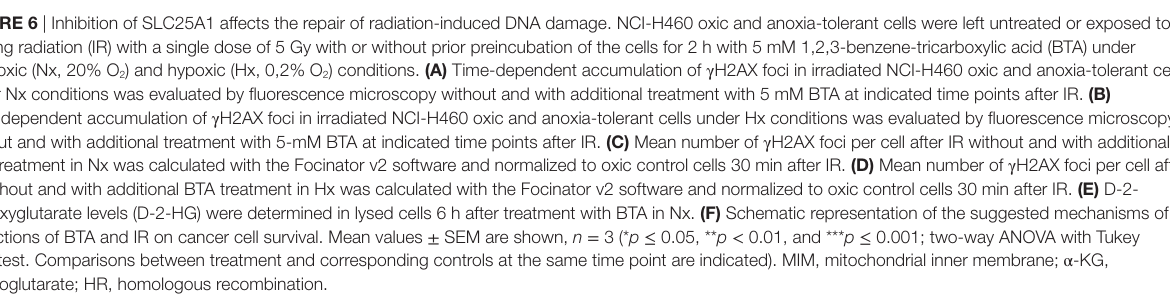
FigUre 6 | Inhibition of SLC25A1 affects the repair of radiation-induced DNA damage. NCI-H460 oxic and anoxia-tolerant cells were left untreated or exposed to ionizing radiation (IR) with a single dose of 5 Gy with or without prior preincubation of the cells for 2 h with 5 mM 1,2,3-benzene-tricarboxylic acid (BTA) under normoxic (Nx, 20% O 2 ) and hypoxic (Hx, 0,2% O 2 ) conditions. (a) Time-dependent accumulation of γ H2AX foci in irradiated NCI-H460 oxic and anoxia-tolerant cells under Nx conditions was evaluated by fluorescence microscopy without and with additional treatment with 5 mM BTA at indicated time points after IR. (B) Time-dependent accumulation of γ H2AX foci in irradiated NCI-H460 oxic and anoxia-tolerant cells under Hx conditions was evaluated by fluorescence microscopy without and with additional treatment with 5-mM BTA at indicated time points after IR. (c) Mean number of γ H2AX foci per cell after IR without and with additional BTA treatment in Nx was calculated with the Focinator v2 software and normalized to oxic control cells 30 min after IR. (D) Mean number of γ H2AX foci per cell after IR without and with additional BTA treatment in Hx was calculated with the Focinator v2 software and normalized to oxic control cells 30 min after IR. (e) D-2- hydroxyglutarate levels (D-2-HG) were determined in lysed cells 6 h after treatment with BTA in Nx. (F) Schematic representation of the suggested mechanisms of the actions of BTA and IR on cancer cell survival. Mean values ± SEM are shown, n = 3 (* p ≤ 0.05, ** p < 0.01, and *** p ≤ 0.001; two-way ANOVA with Tukey post-test. Comparisons between treatment and corresponding controls at the same time point are indicated). MIM, mitochondrial inner membrane; α -KG, α -Ketoglutarate; HR, homologous